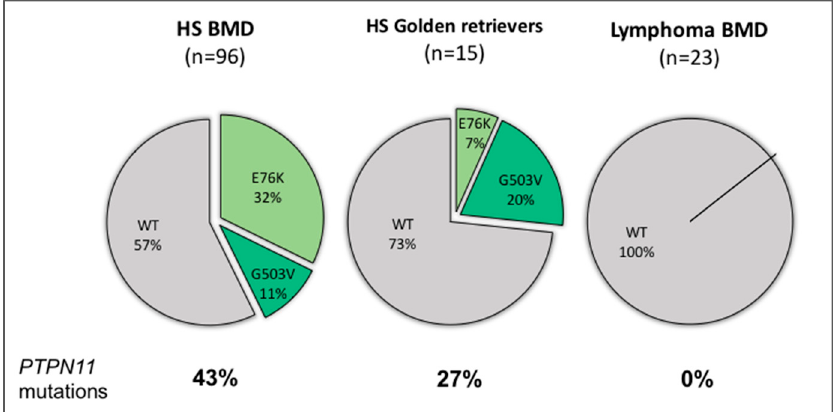
Figure 3. Frequency of tumor PTPN11 mutation status based on breed, and disease type.